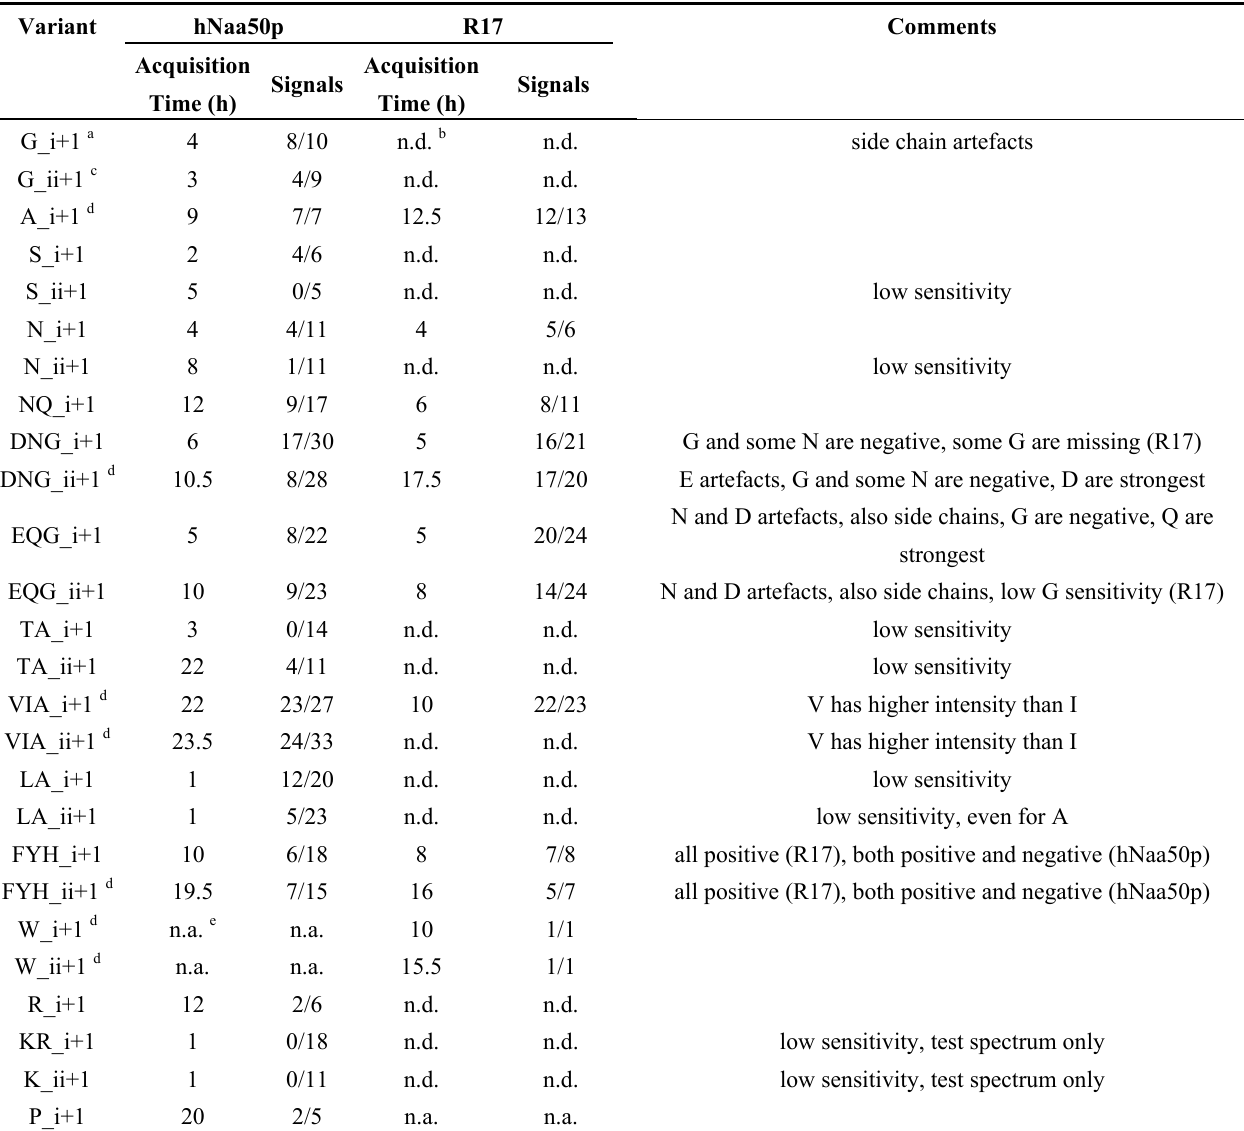
Table 3. Overview of the MUSIC experiments that were acquired on the two-medium sized